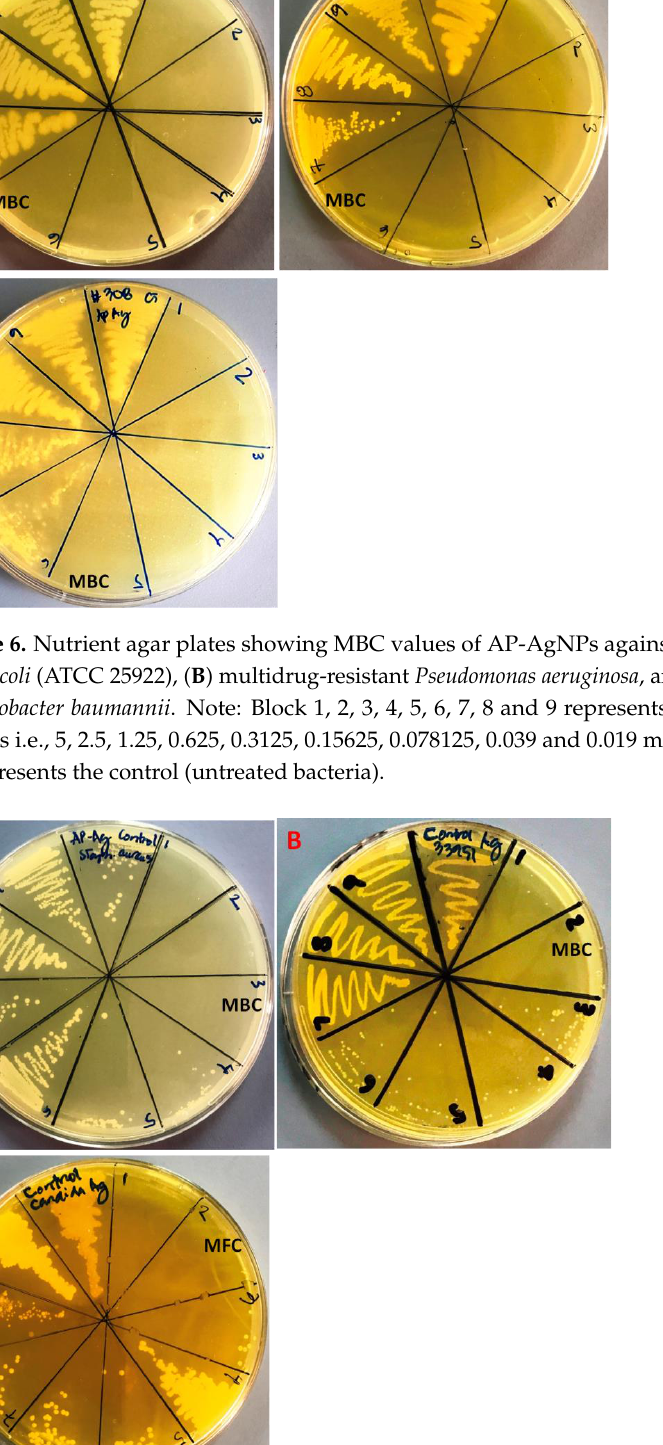
5, 2.5, 1.25, 0.625, 0.3125, 0.15625, 0.078125, 0.039 and 0.019 mg/mL, respectively, while 10 represents the control (untreated bacteria and